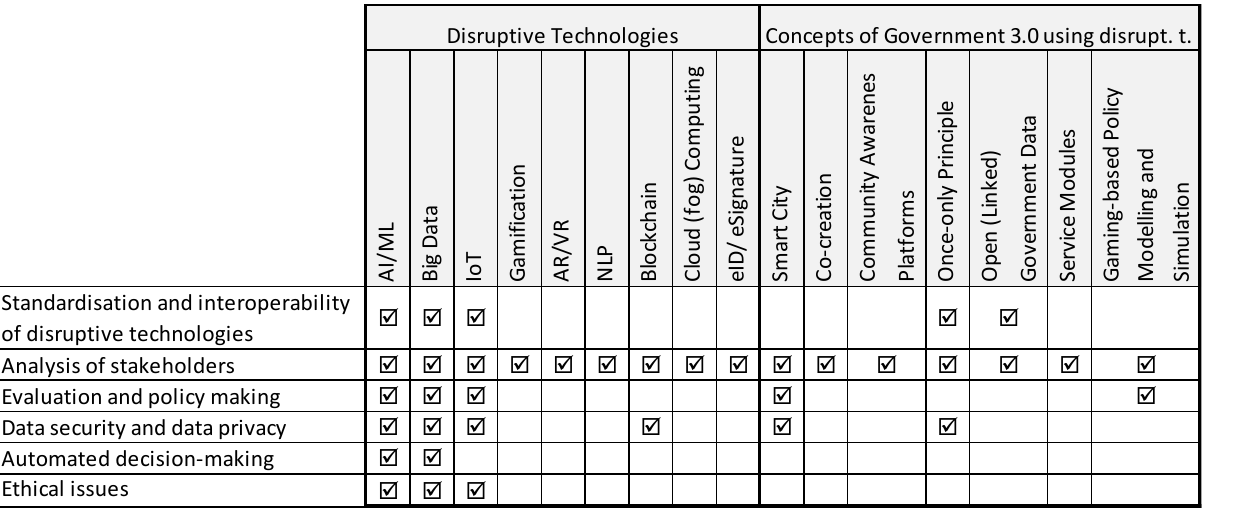
Table 2: Correspondence of research needs with disruptive technology use in public